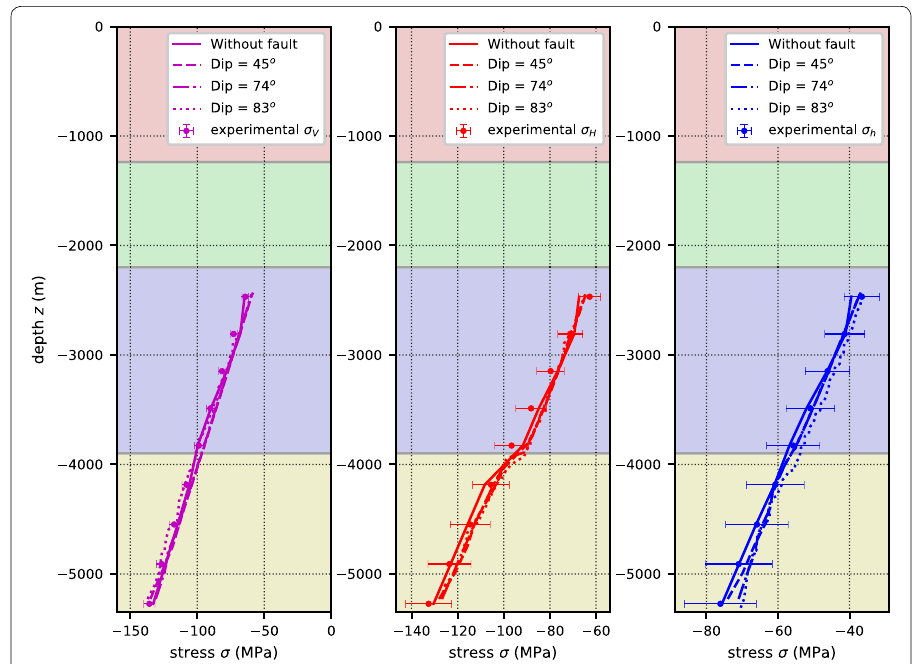
Fig. 8 Simulated stress–depth profiles [(left) vertical σ v and (middle) horizontal minimum σ h and (right) maximum σ H ] obtained at the maximum ascending flow profile from models including the Rittershoffen fault with different dips and compared to the model without